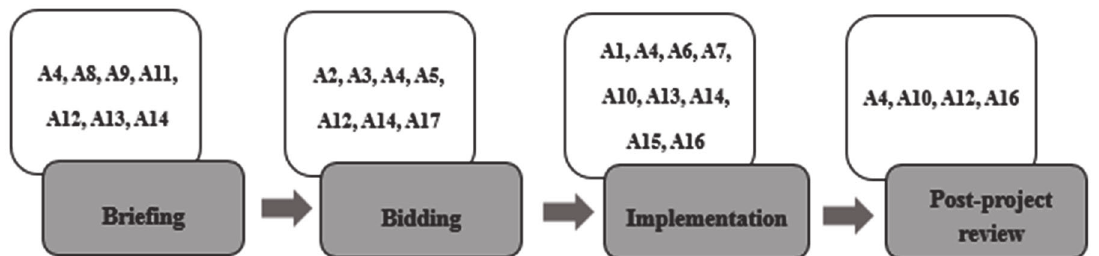
Figure 1. Four stages of determinant